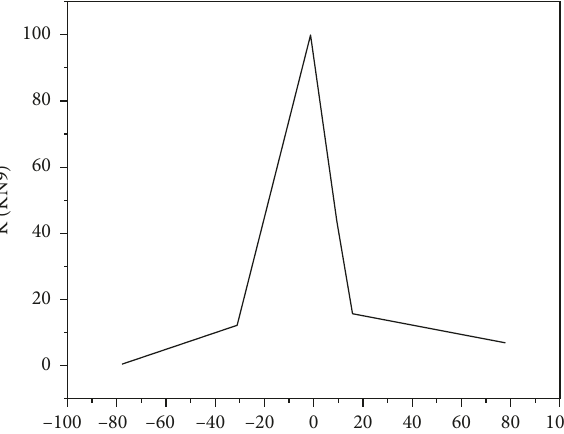
Figure 3: Stiffness degradation curve of each